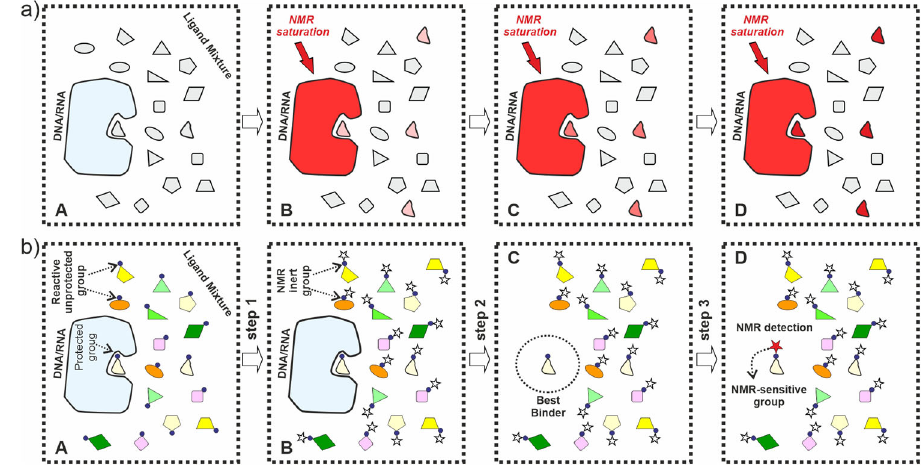
Fig. 1 STD vs reactivity-based NMR screening. a Schematic representation of the STD-NMR experiment commonly used for the identi fi cation of binders. Upon saturation of the receptor signals, magnetisation is transferred to the ligands. b Concept fi gure illustrating a feasible strategy for a reactivity-based screening protocol. The expected decrease in ligand reactivity associated to complex formation is exploited to preferentially label the best binders within a mixture of